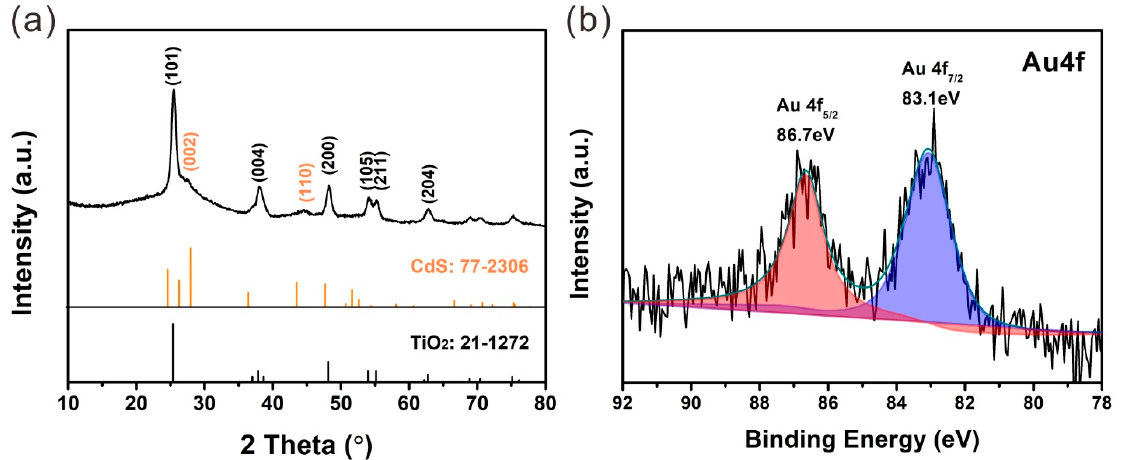
Figure 3. ( a ) XRD pattern of 3DOM TiO 2 -Au-CdS, along with the JCPDS cards of anatase TiO 2 and hexagonal CdS; ( b ) the high-resolution XPS spectrum of Au 4f in 3DOM TiO 2 -Au-CdS.